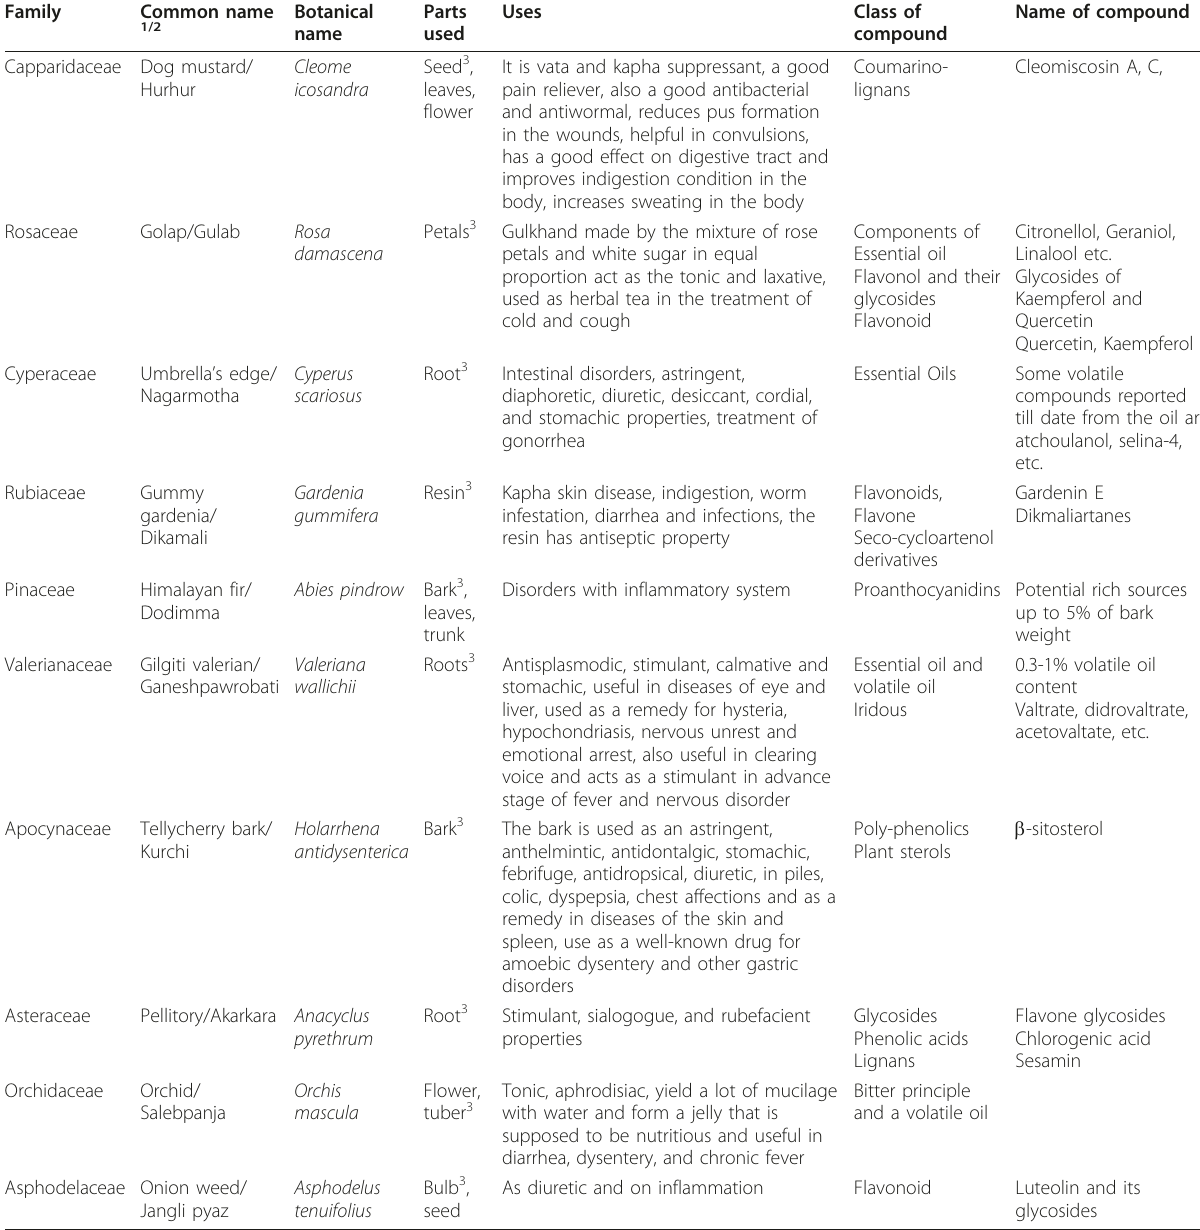
Table 1 Properties of Unani plants used in this study